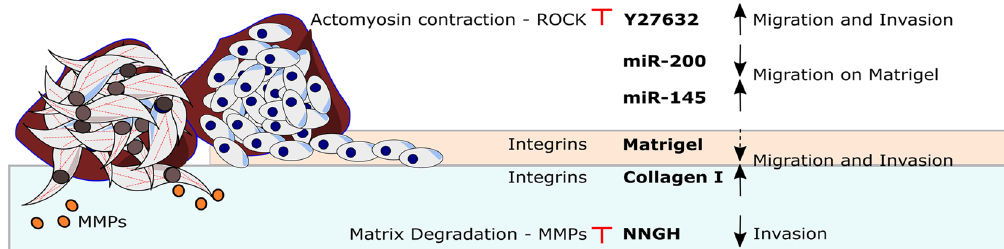
Figure 7. The invasiveness of endometrial spheroids depends both on the cell type (stromal St-T1b and ESCs in brown, epithelial 12Z in blue) and ECM. Invasion and spreading is strongly enhanced by exposed collagen I. Migration on Matrigel is modulated by microRNAs and ROCK inhibitor increases invasion and migration on this substrate. Invasion on collagen is MMP-dependent. Red marks signify experimental intervention. Blunt arrow signifies that an inhibitor was added. Black arrows show the effect of the intervention. Dashed arrow suggest weak